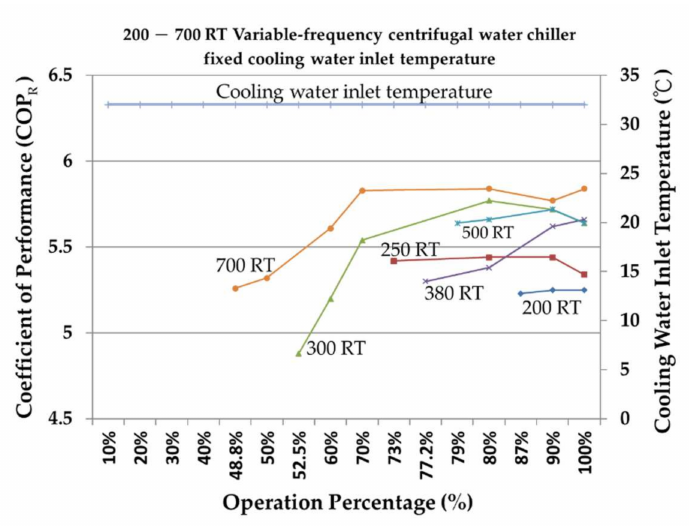
Figure 9. Fixed-cooling water inlet temperature COP R of the 200–700 RT variable-frequency water chiller.